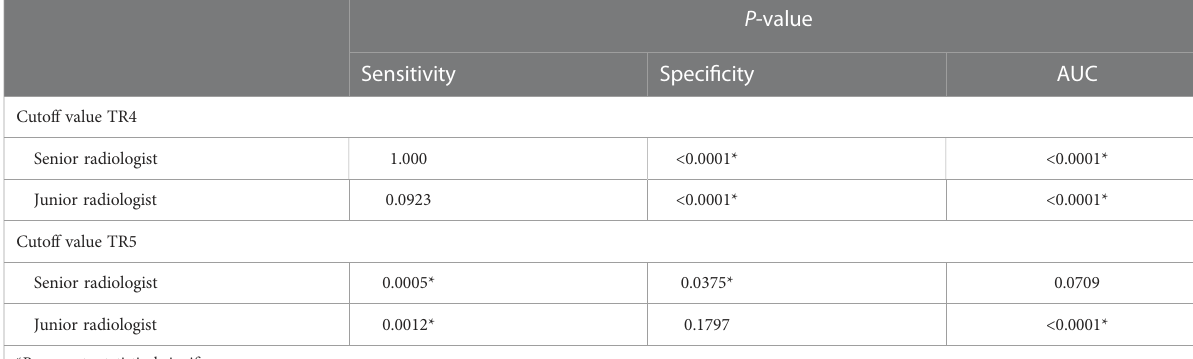
TABLE 3 Quantitative indicators for the two radiologists compared with the CAD